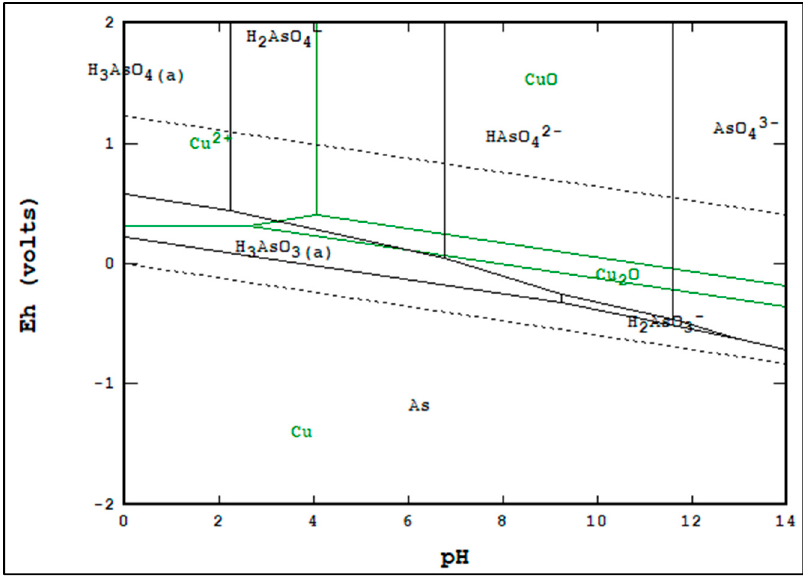
Figure 2. Copper (0.173 M) and arsenic (0.0320 M) Pourbaix diagram overlay.